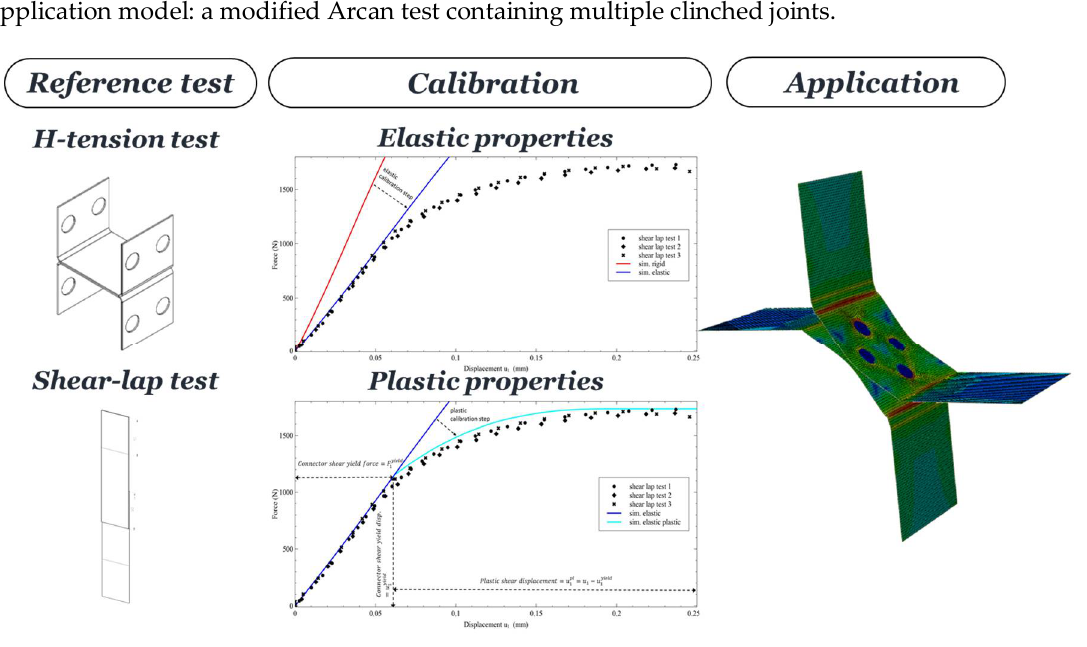
Figure 1. Equivalent modelling strategy